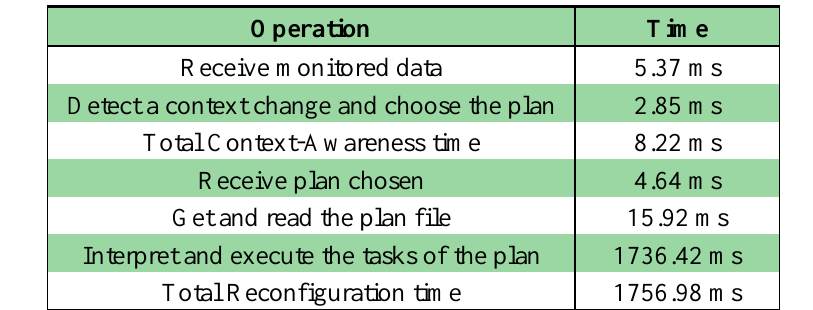
Table 2. Latency for the reconfiguration of the